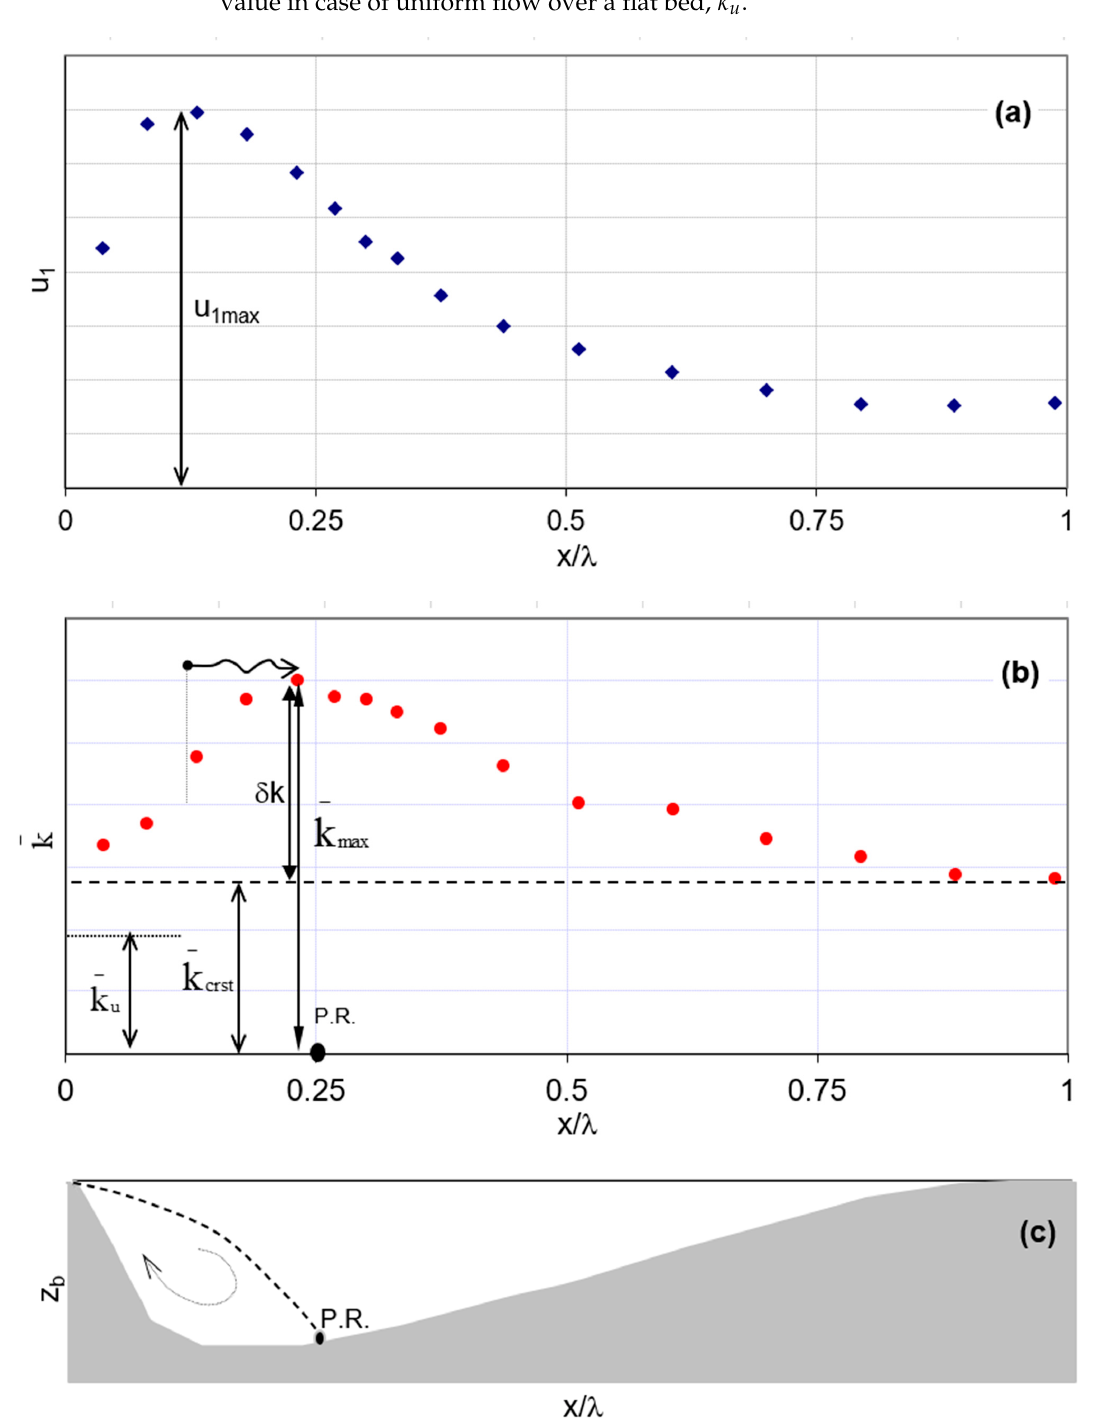
Figure 3. ( a ) A typical spatial variation for the integral velocity u 1 over one wavelength of a train of bedforms; ( b ) a typical variation for the depth-averaged turbulent kinetic energy, for fully developed turbulent flow; ( c ) bed geometry of one wavelength for a train of dunes.